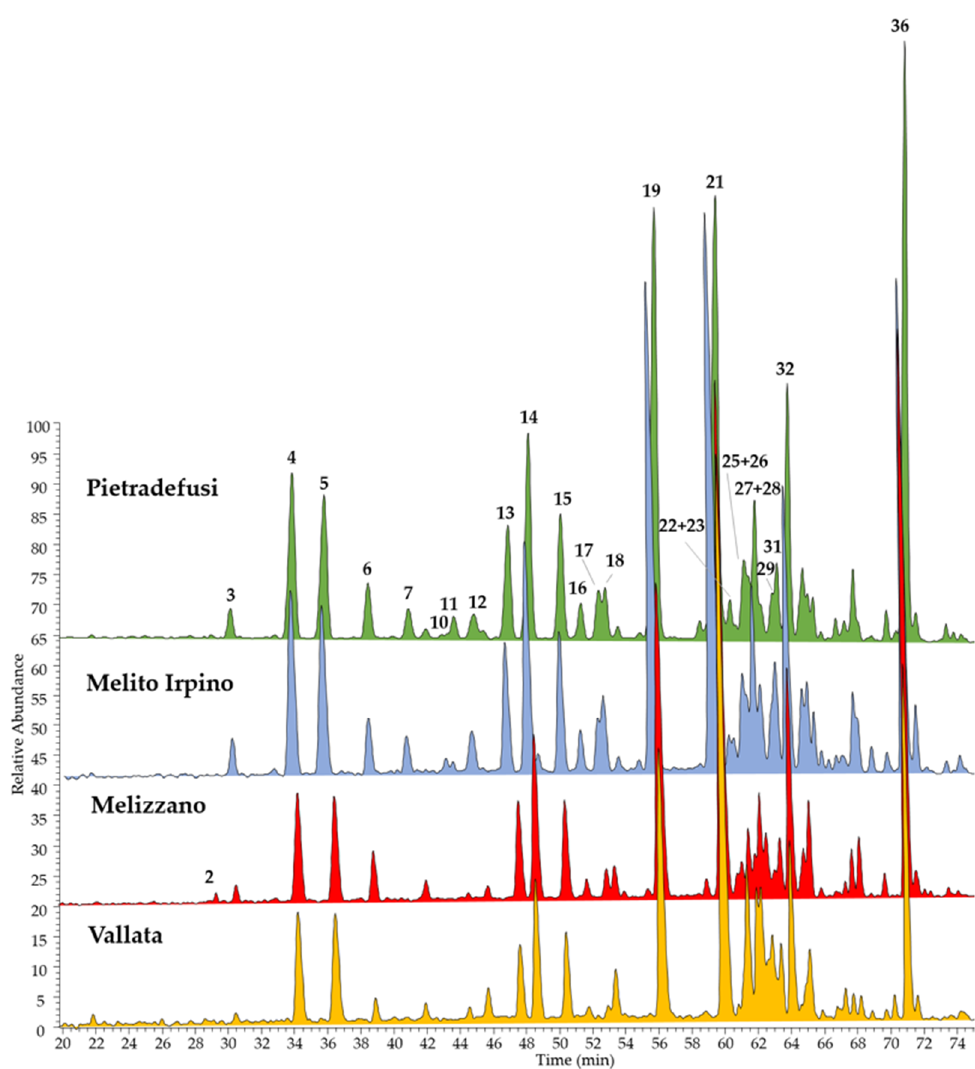
Figure 2. LC-ESI-MS / MS chromatograms, registered in positive ion mode, of four extracts of Italian Figure 2. LC-ESI-MS/MS chromatograms, registered in positive ion mode, of four extracts of Italian propolis collected in Campania Region. Peak data are shown in Table propolis collected in Campania Region. Peak data are shown in Table 2.